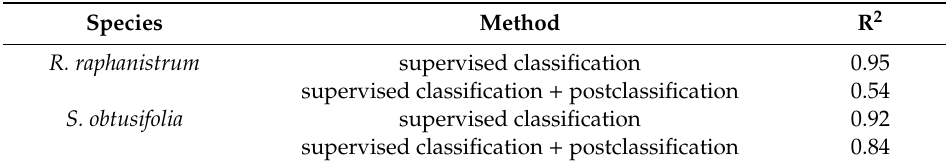
Table 2. Comparison of the relationship between relative emergence from true counts and the relative cumulative pixels achieved by two methods (supervised classification alone and in combination with postclassification).